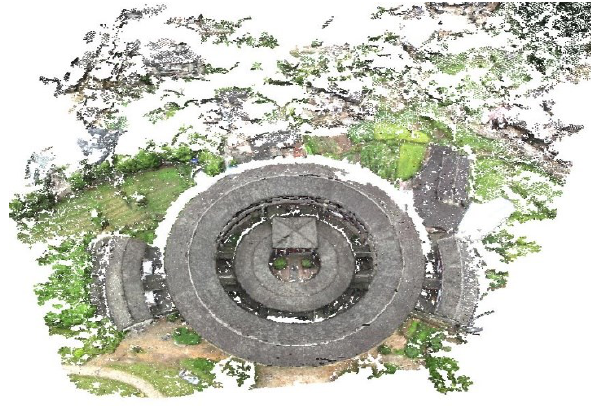
Figure 4 3D point clouds from UAV blur-free video image sequences